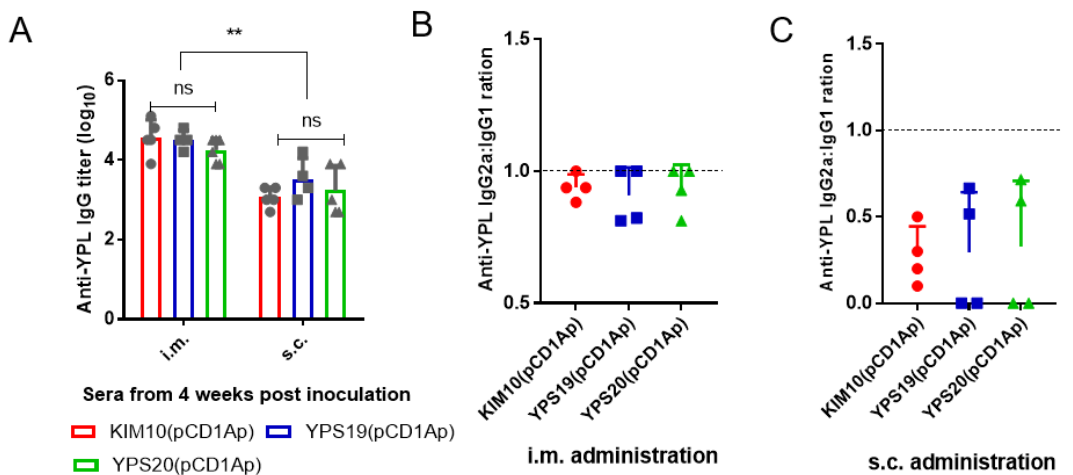
Figure 4. Antibody response in sera of mice administrated i.m. or s.c. with Y. pestis KIM10(pCD1Ap), YPS19(pCD1Ap), YPS20(pCD1Ap), respectively at week 4 post administration. A Y. pestis whole cell lysate (YPL) was used as the coating antigen. ( A ) Serum IgG responses in mice by i.m. or s.c. administration; ( B ) Ratio of serum IgG2a and IgG1 responses in mice by i.m. administration; ( C ) Ratio of serum IgG2a and IgG1 responses in mice by s.c. administration. The two-way ANOVA, ** , the p value was less than